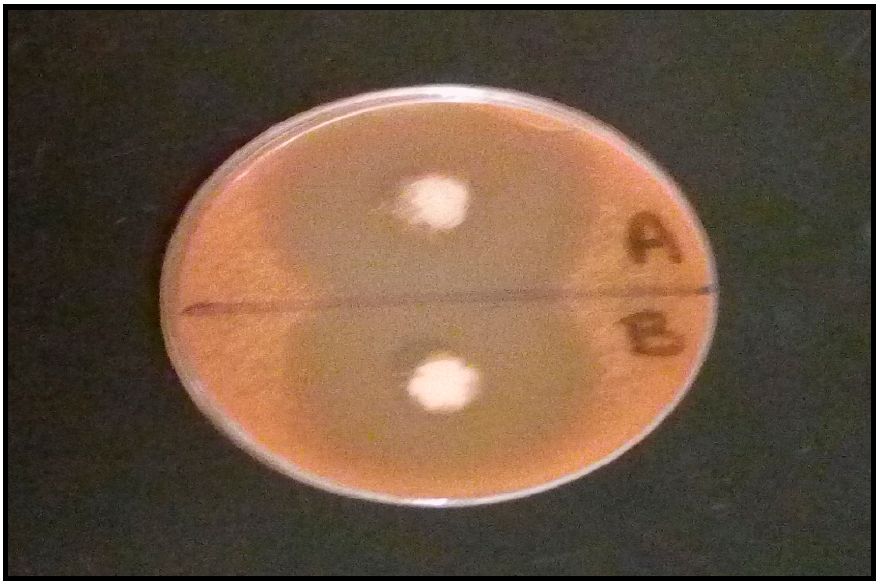
Figure 10. Antifungal activity test showing zone of inhibition for MIC transfersomal gel ( A ) and (Daktarin® cream 2%) ( B ).